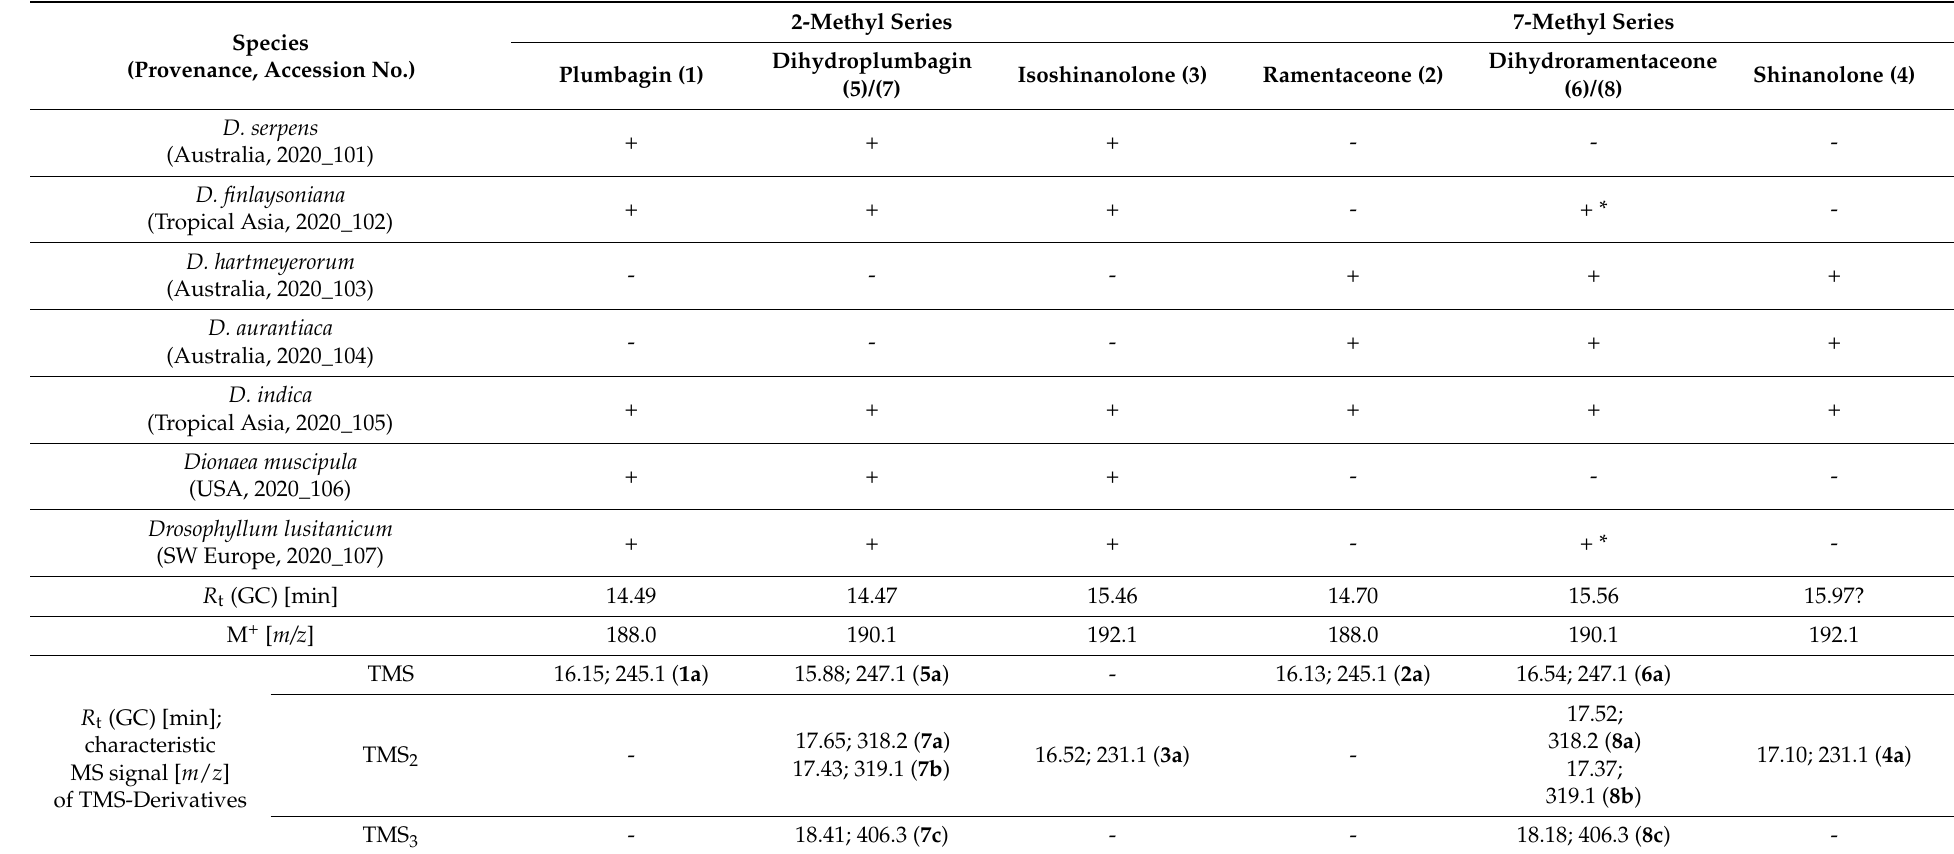
Table 1. Naphthoquinone derivatives identified in petroleum ether extracts of the plant material investigated in this